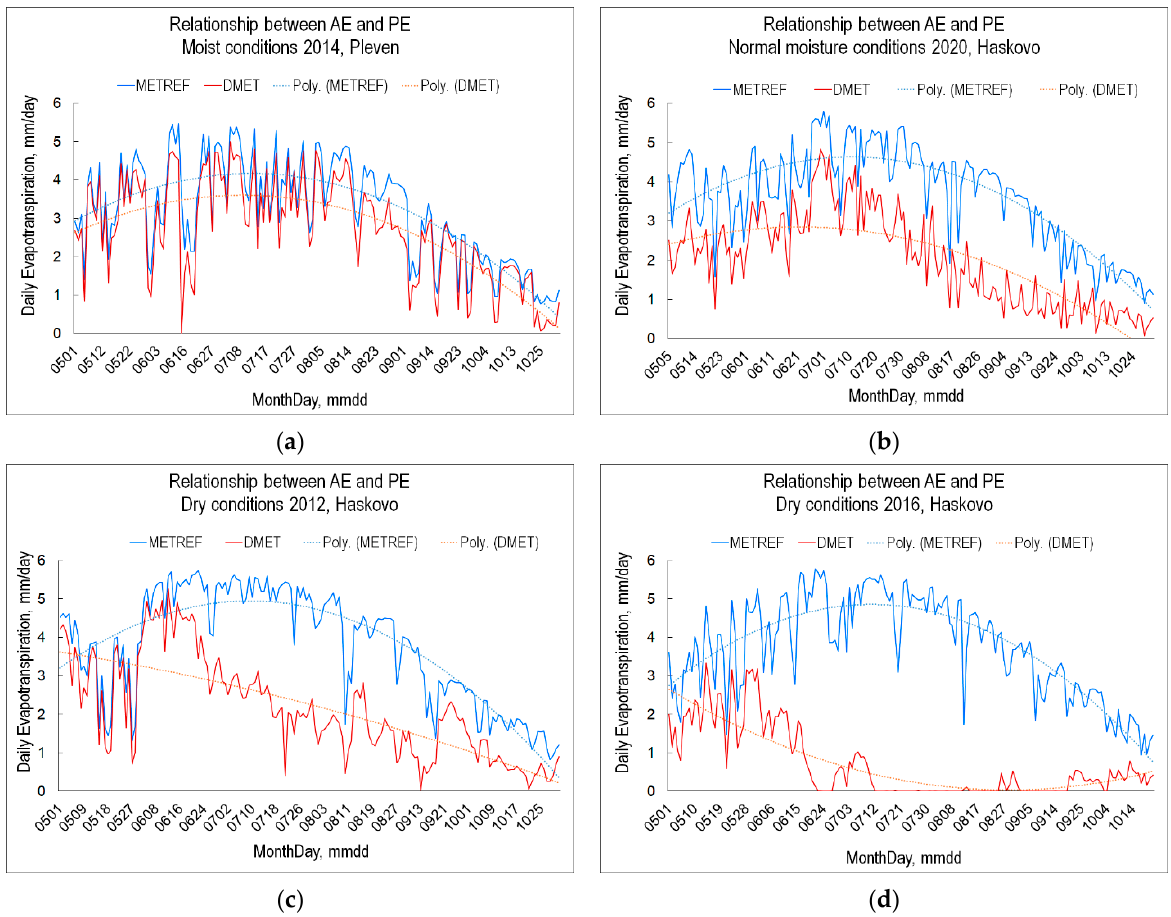
Figure 6. Seasonal (May–October) courses (daily values) of AE (DMET) and PE (METREF) and their trends (described with polynomial functions) under different environmental conditions: ( a ) moist; ( b ) normal; ( c , d )